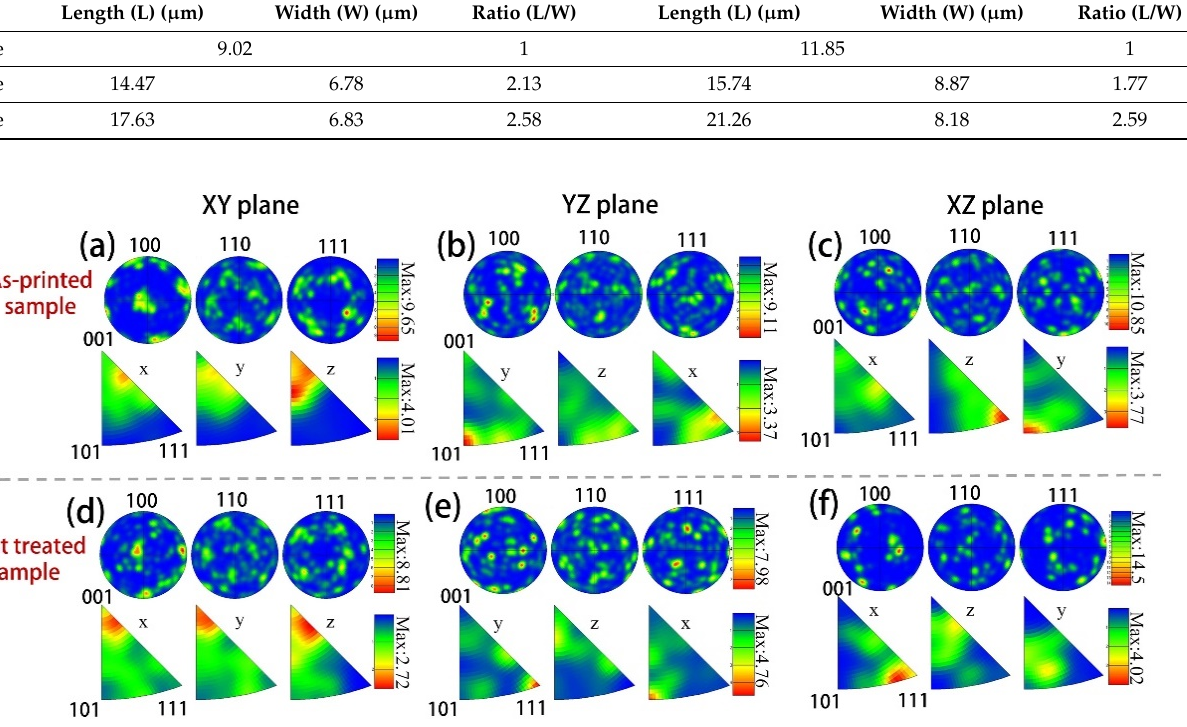
Figure 4. The pole figures (PFs) and inverse pole figures (IPFs) of ( a – c ) as-printed and ( d – f ) heat-treated nickel-based superalloy samples for XY, YZ, and XZ planes, respectively. Figure 5 indicates the substructures and precipitates under TEM of the as-printed and heat-treated nickel-based superalloy specimens. In Figure 5a, a clear cellular microstructure with fine subgrains is observed in the as-printed nickel-based superalloy specimen. The primary grains (Figure 2) were fractionized into smaller regions by a network of